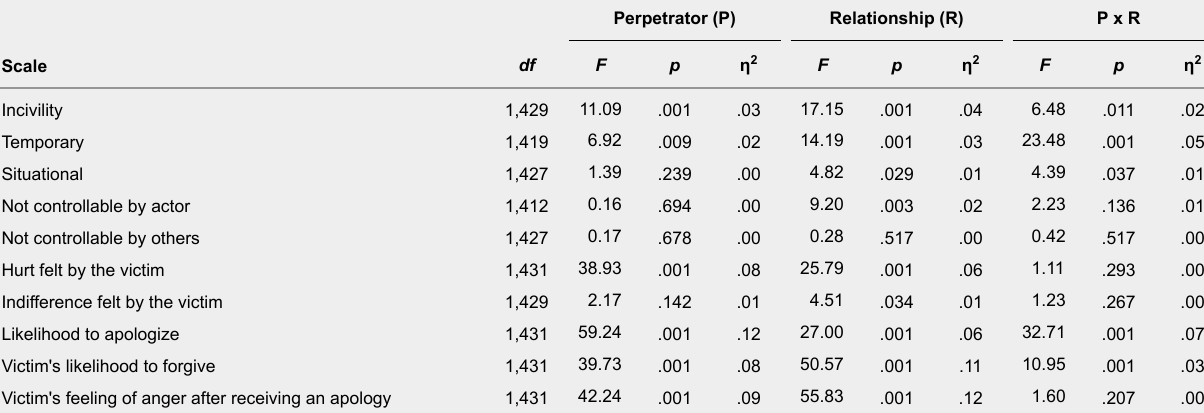
Analysis of Variance Results for Study